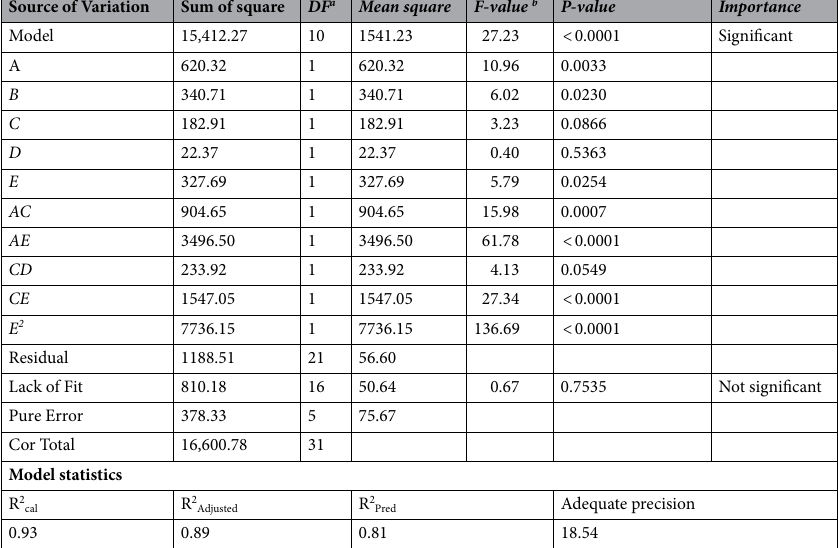
acquired from the analysis of the fortified urine samples were compared with the relative spiked mobile phase.